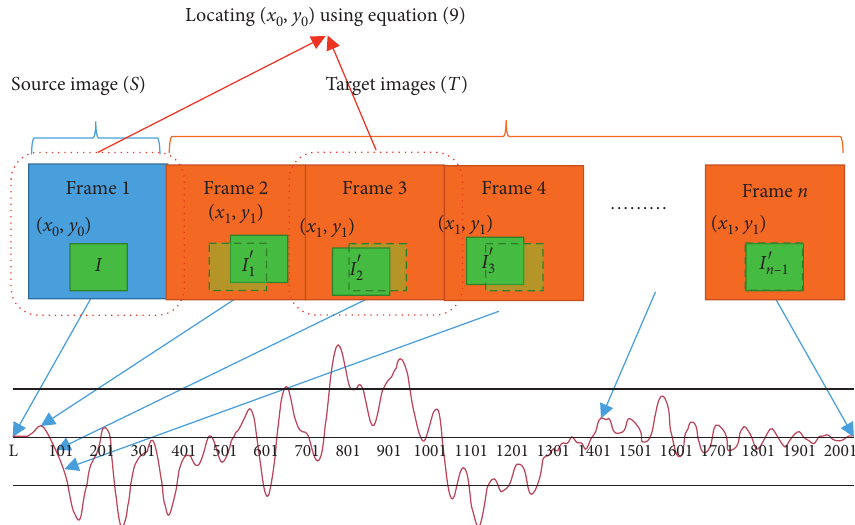
Figure 4: A series of frames in a video and the corresponding computed time history of displacements.